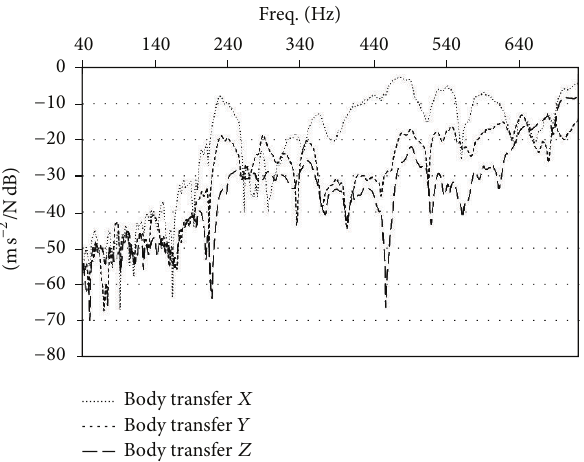
Figure 3: Body transfer function of RH mount at different direc- tions.